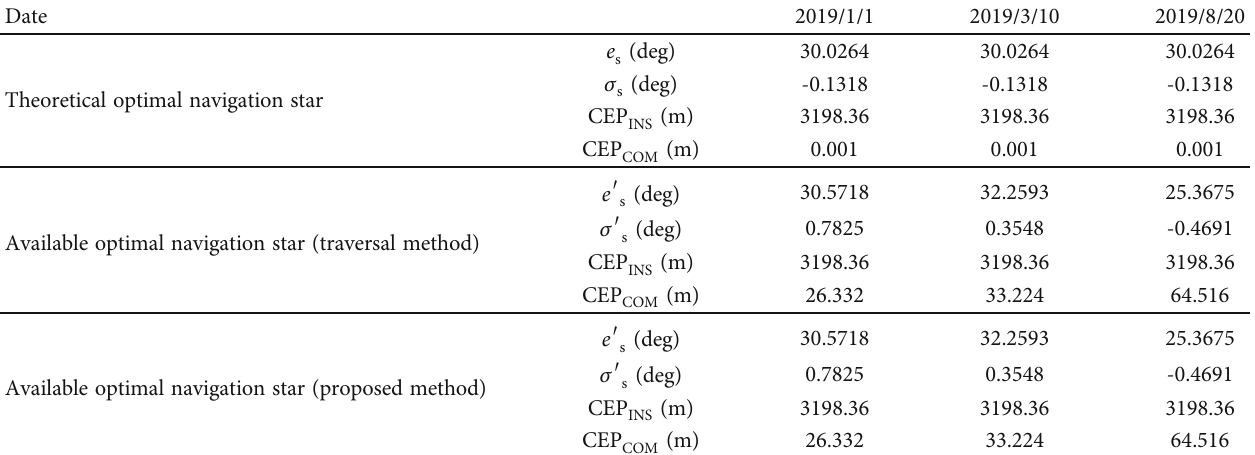
Table 9: The available optimal navigation stars for the 12000 km launch